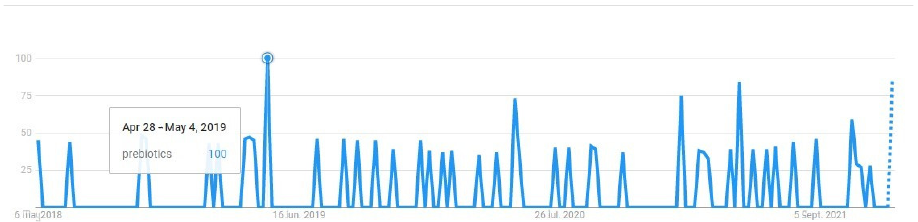
Figure 2. The level of interest in “prebiotics” from May 2018 to September 2021 (https://trends.google.com/, accessed on 6 January